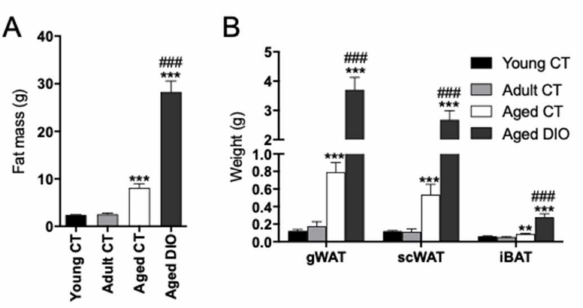
Figure 1. Changes in adipose tissue mass induced by aging and obesity in female mice. ( A ) Whole body fat mass measured by magnetic resonance technology in non-fasted mice fed a control diet (CT) at 2 (young CT), 6 (adult CT) and 18 (aged CT) months of age or aged under a HFD up to 18-month-old (aged DIO); ( B ): weights of the different adipose tissue depots in CT mice (young, adult, and aged) and in aged DIO mice after an overnight fasting. Data are expressed as mean ± SEM. ** p < 0.01, *** p < 0.001 vs. young CT mice; ### p < 0.001 vs. aged CT mice (n = 7–9).